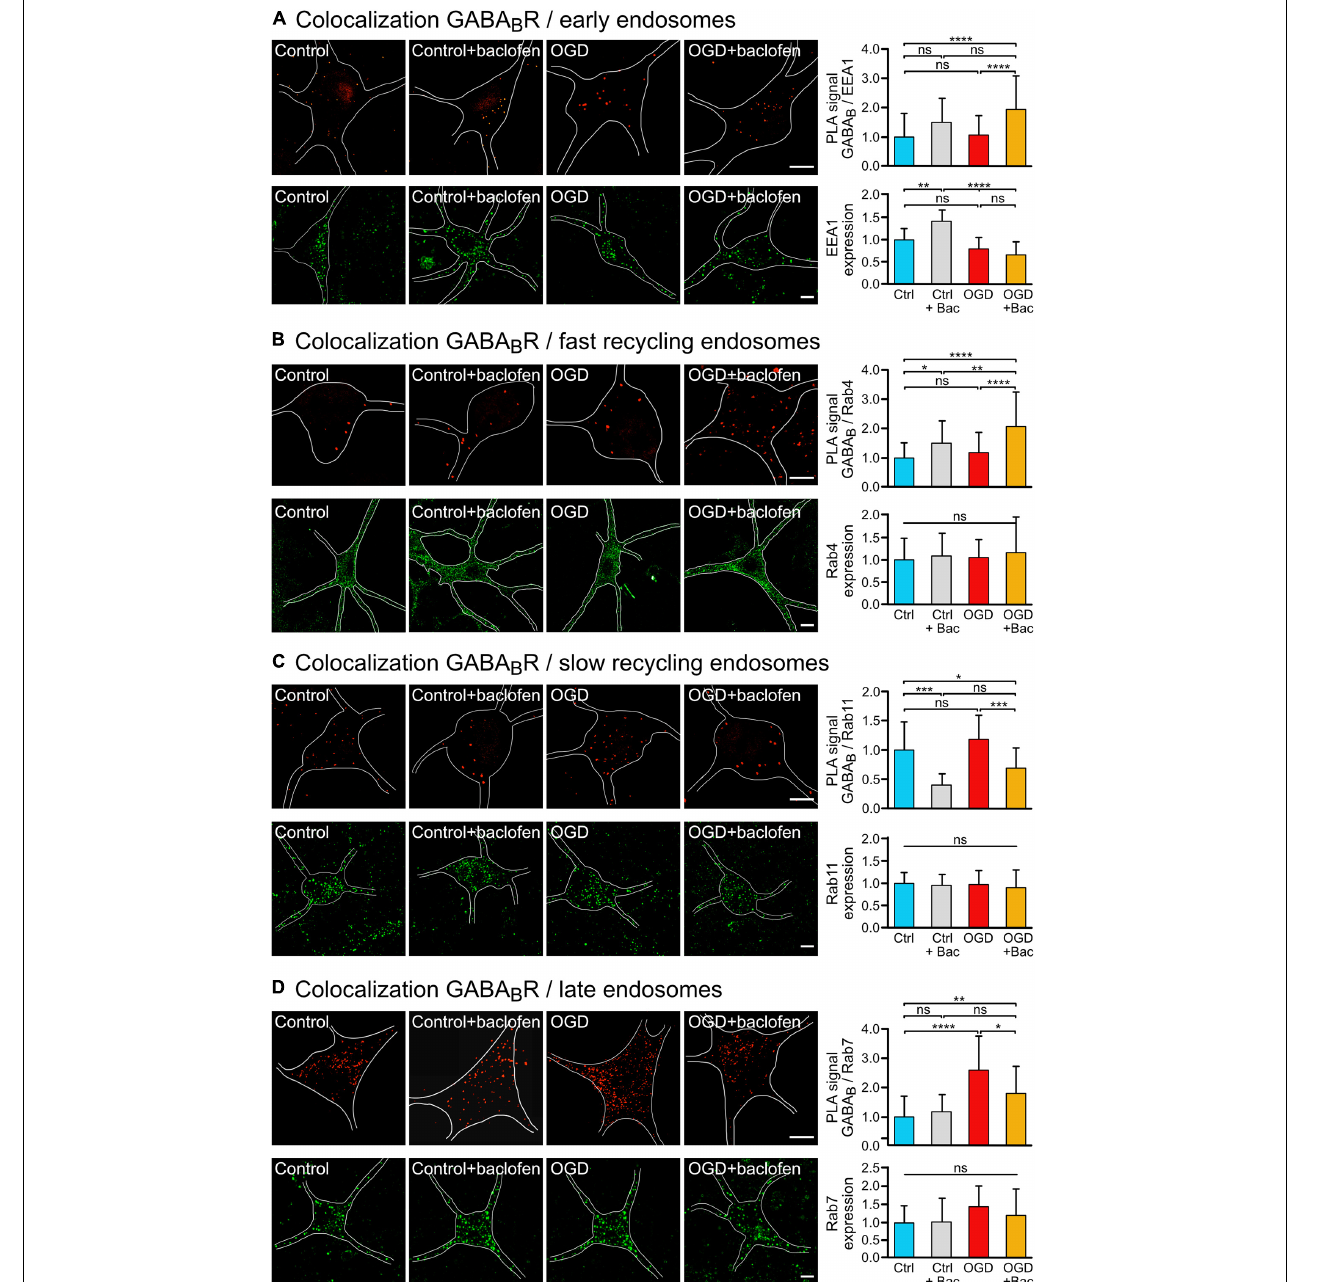
FIGURE 2 | Sustained baclofen stimulation of GABA B receptors reduced sorting of the receptors to lysosomal degradation after OGD and increased fast recycling. Cultured neurons were subjected (OGD) or not (Ctrl) to OGD for 1 h followed by incubation with baclofen (+Bac). Neurons were analyzed 16 h after OGD for the colocalization of GABA B receptors with endosomal markers by in situ PLA (upper panels) and for expression of the marker proteins (lower panels) using antibodies directed against GABA B 2 and EEA1 (A) , Rab4 (B) , Rab11 (C) , and Rab7 (D) . (A) Baclofen treatment increased the colocalization of GABA B 2 with the early endosome marker EEA1 after OGD. Left, representative images depicting colocalization (upper panels) and EEA1 expression (lower panels) (scale bar, 10 µ m). Right: the bar graphs depicts the quantification of PLA signals and fluorescence intensities. The data represent the mean ± SD of 28–68 neurons per condition from thee independent experiments for in situ PLA and 14–20 neurons per condition for EEA1 expression. Two-way ANOVA followed by Tukey’s post hoc test (ns, p > 0.05; **, p < 0.005; ****, p < 0.0001). (B) Baclofen treatment increased the colocalization of GABA B 2 with the fast recycling endosome marker Rab4. Left, representative images (scale bar, 10 µ m). Right: the bar graphs depicts the quantification of PLA signals and fluorescence intensities of Rab4 expression. The data represent the mean ± SD of 39–46 neurons per condition from thee independent experiments for in situ PLA and 49–70 neurons per condition for Rab4 expression. Two-way ANOVA followed by Tukey’s post hoc test (ns, p > 0.05; *, p < 0.05; **, p < 0.01; ****, p < 0.0001). (C) Baclofen treatment reduced colocalization of GABA